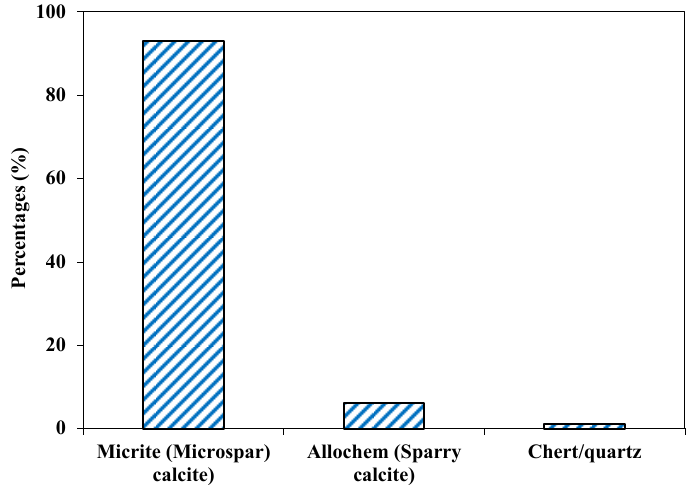
Figure 3. Mineralogical composition of Shalozan aggregates.